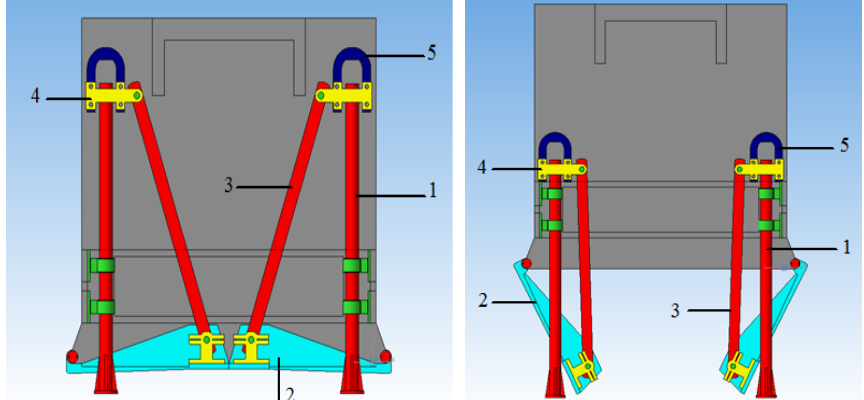
Fig. 6. Operational scheme of container levers during loading and